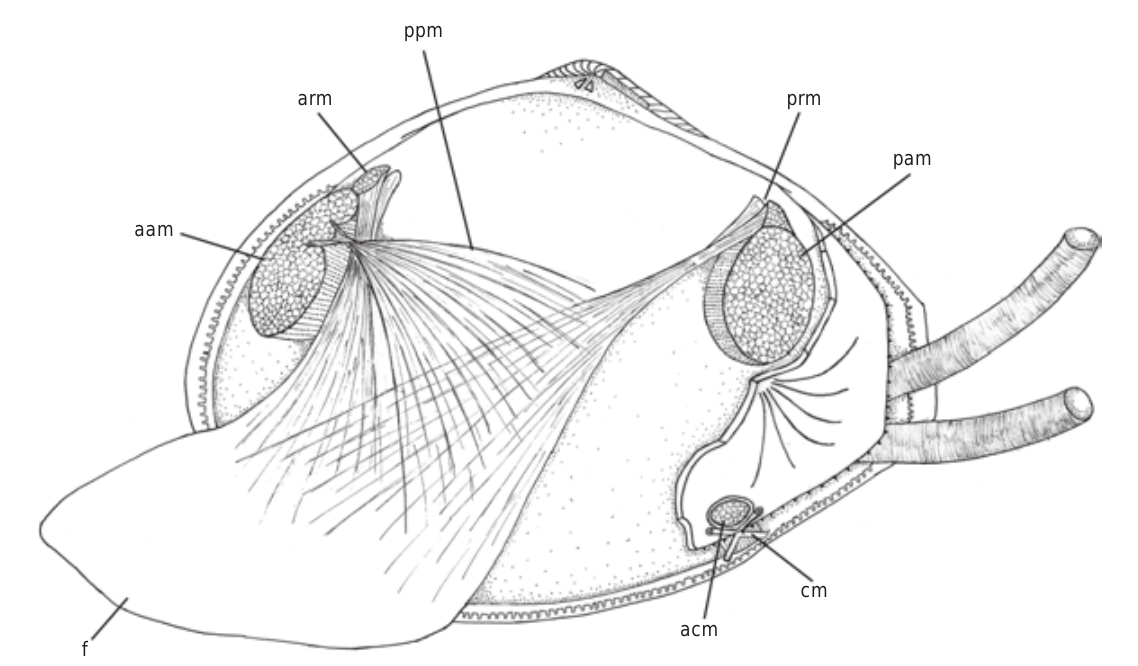
Figure 6. Macoma biota : the arrangement of the musculature. (aam) anterior adductor muscle, (acm) accessory adductor muscle, (arm) anterior pedal retractor muscle, (cm) cruciform muscle, (f) foot, (pam) posterior adductor muscle, (ppm) pedal protractor muscle, (prm) posterior pedal retractor muscle. Scale bar: 1.5